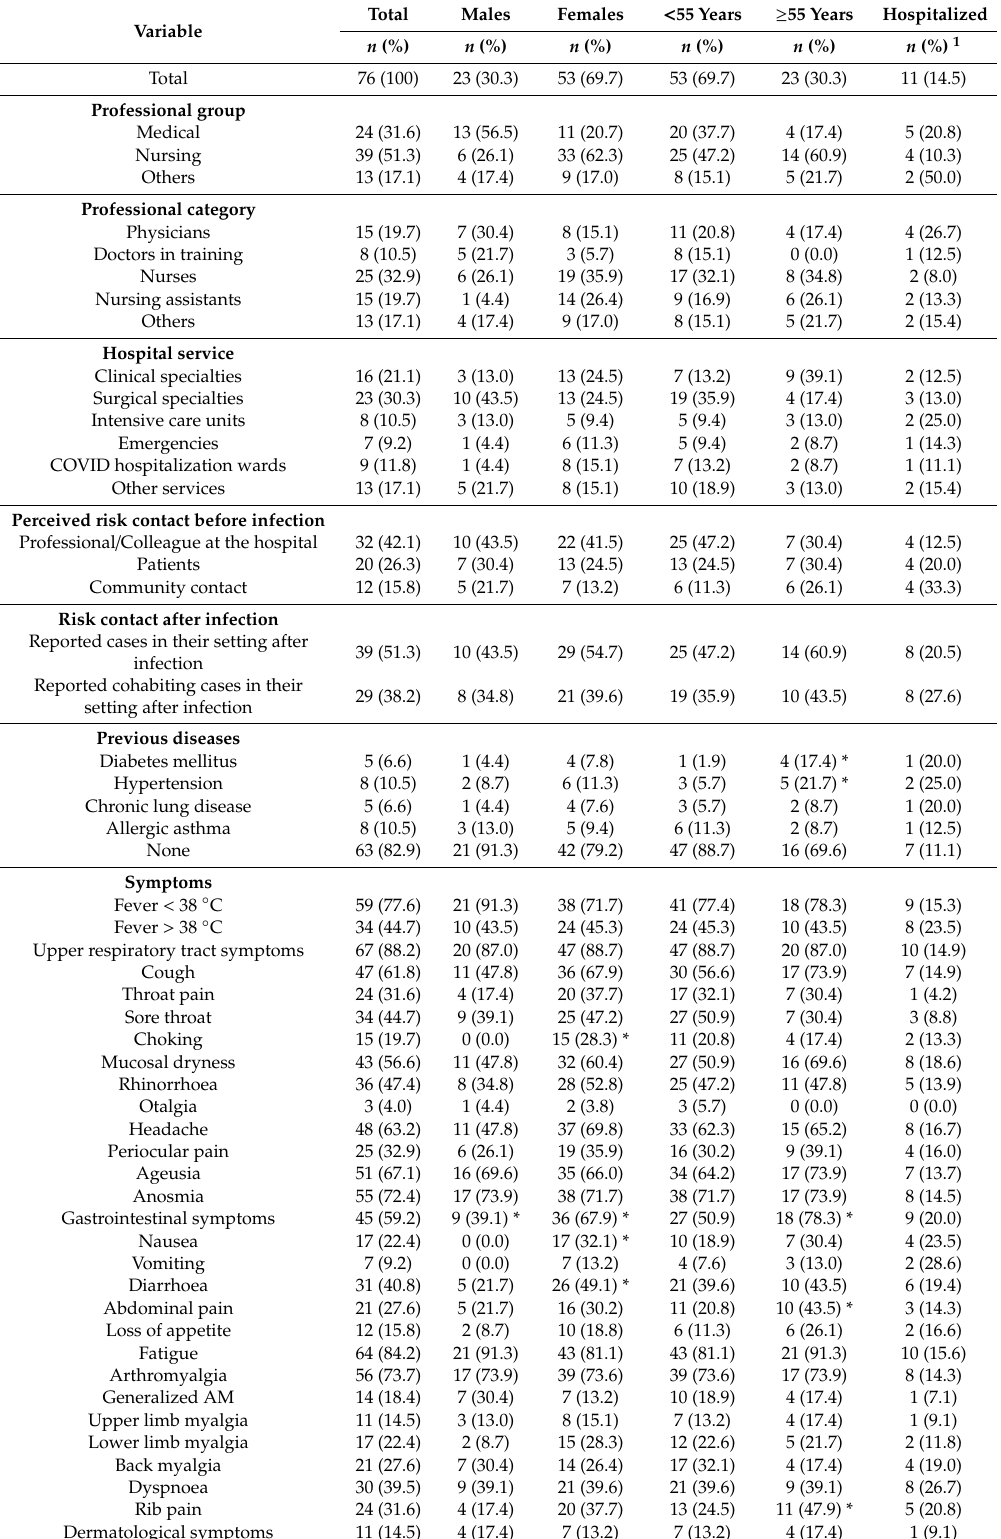
Table 1. Distribution of baseline characteristics in the whole sample and according to sex and age, and proportion of hospitalizations in each